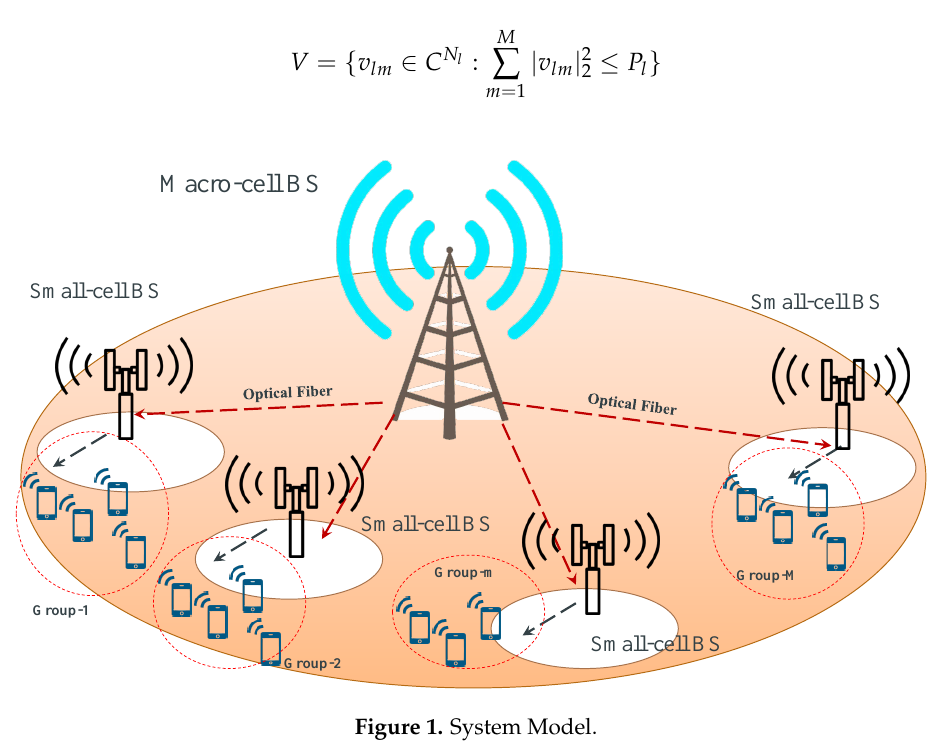
Figure 1. System